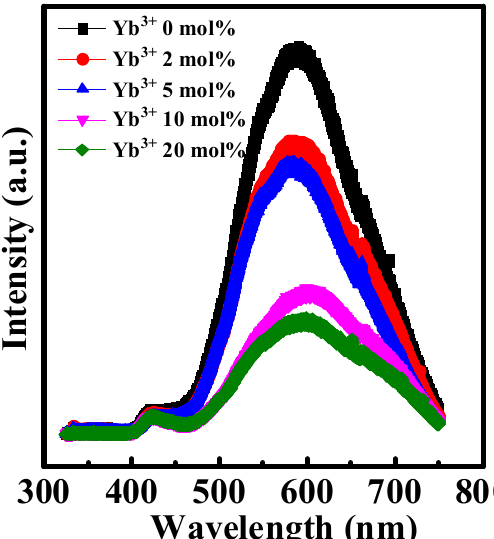
Figure 4. PL patterns of In-Yb-O with indicated Yb concentrations.